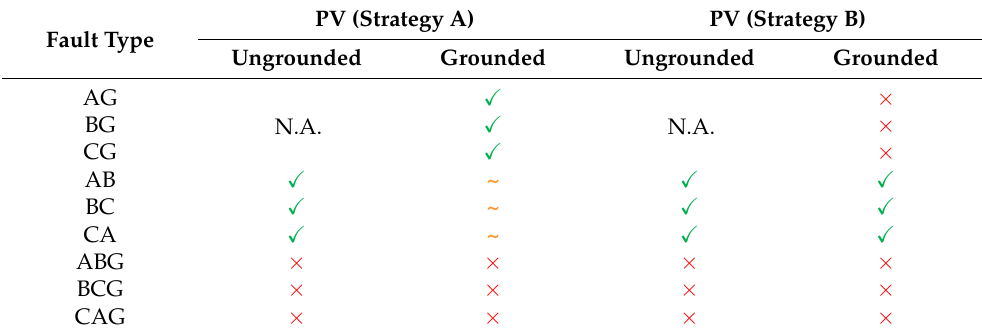
Table 2. Study cases to evaluate negative current injection in current protection relays located in distribution grids ( K 1 = K 2